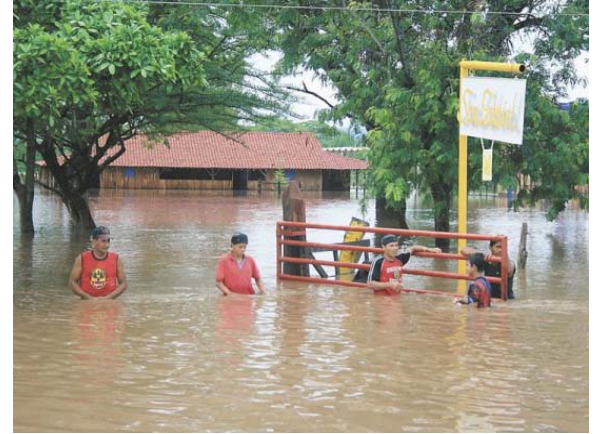
Figure A1. Flood in the Department of Leon Nicaragua (photo credit: Gilberto Moreno).